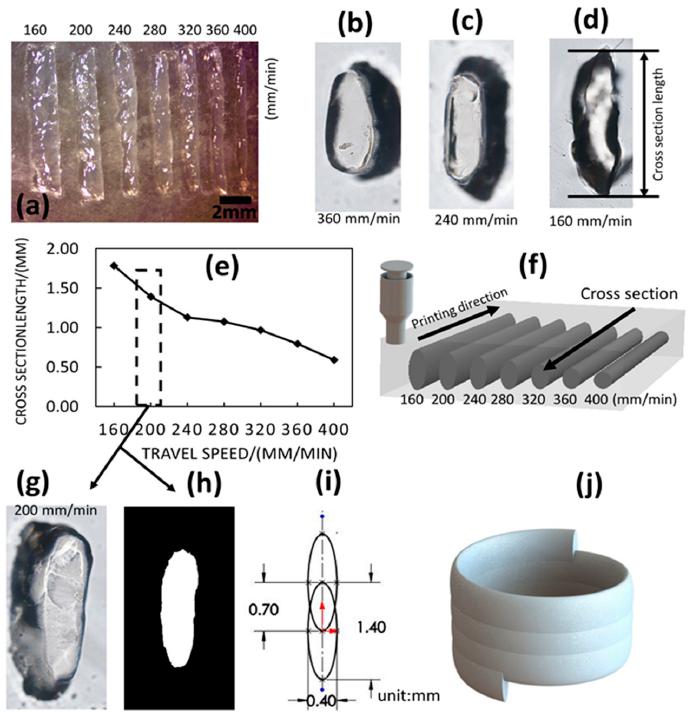
Figure 4. The cross-section geometry of the printed filament within a support bath medium with travel speed from 160 mm/min–400 mm/min, at flowrate of 4.8 mL/h: ( a ) the image of the filaments (laid flat, side view); ( b – d ) cross section view of three selected filaments. The length increases as the travel speed decreases; ( e ) measurements of the cross section length as a function of travel speed; ( f ) schematic shows the cross section of printed filament. The filament is elongated in z direction due to the slow travel speeds; ( g ) the cross section of the filament printed at travel speed of 200 mm/min; ( h ) binary image of the cross section view; ( i ) the schematic shows 2 filament with overlap that enables the fusion; ( j ) the 3D model of a 4 layers of helical structure with overlap of two adjacent layers.